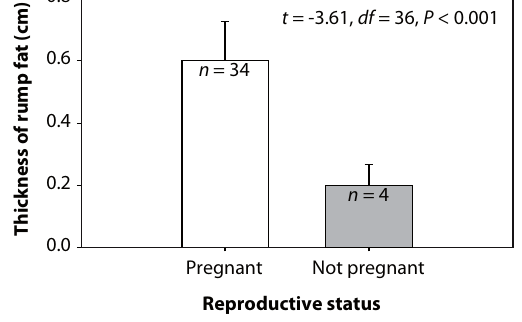
Fig. 3. Ultrasound estimates of thickness of rump fat (cm, x – ± 95% CI) by reproductive status for woodland caribou in the Greater Besa-Prophet Area, northern British Columbia, Canada,